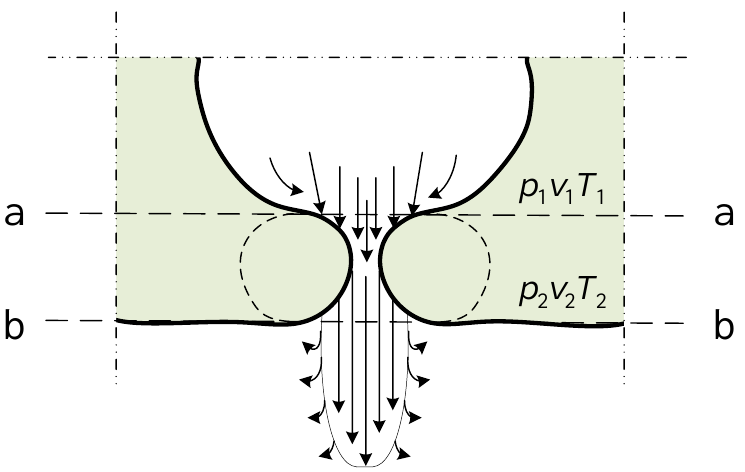
Figure 4. Diagram of gas flow along the plant leaf stoma: gas flow cross-sections a – a and b – b.